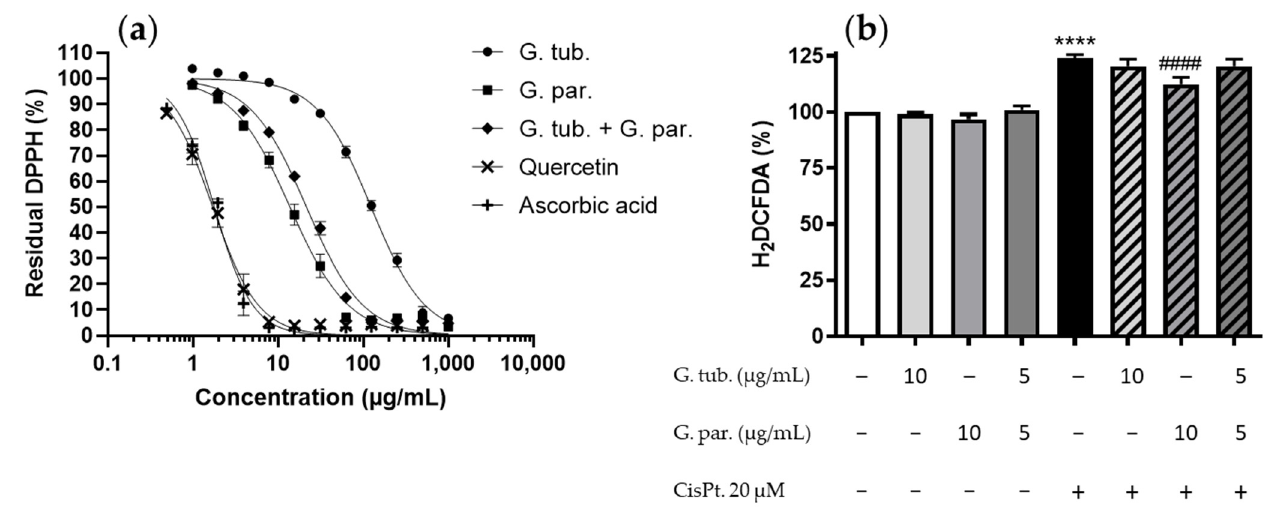
Figure 3. Antioxidant potential of G. tub., G. par. and their association represented by ( a ) their scavenger activity based on residual DPPH percentages on serial 2-fold dilutions (starting concentration from 1000 µg/mL; while standards were added at 500 µg/mL); ( b ) normalized fluorescence of H 2 DCFDA, expressed as percentages compared to controls after a 24 h treatment with CisPt 20 µM and/or the G. tub. extract (10 µg/mL); the G. par. extract (10 µg/mL) or the G. tub. and G. par. association extract (each at 5 µg/mL). Results are shown as mean ± SD of three independent experiments (**** p < 0.0001 compared to controls; #### p < 0.0001 compared to CisPt 20 µM). The signs + and − indicate the presence or the absence of the corresponding treatment respectively.